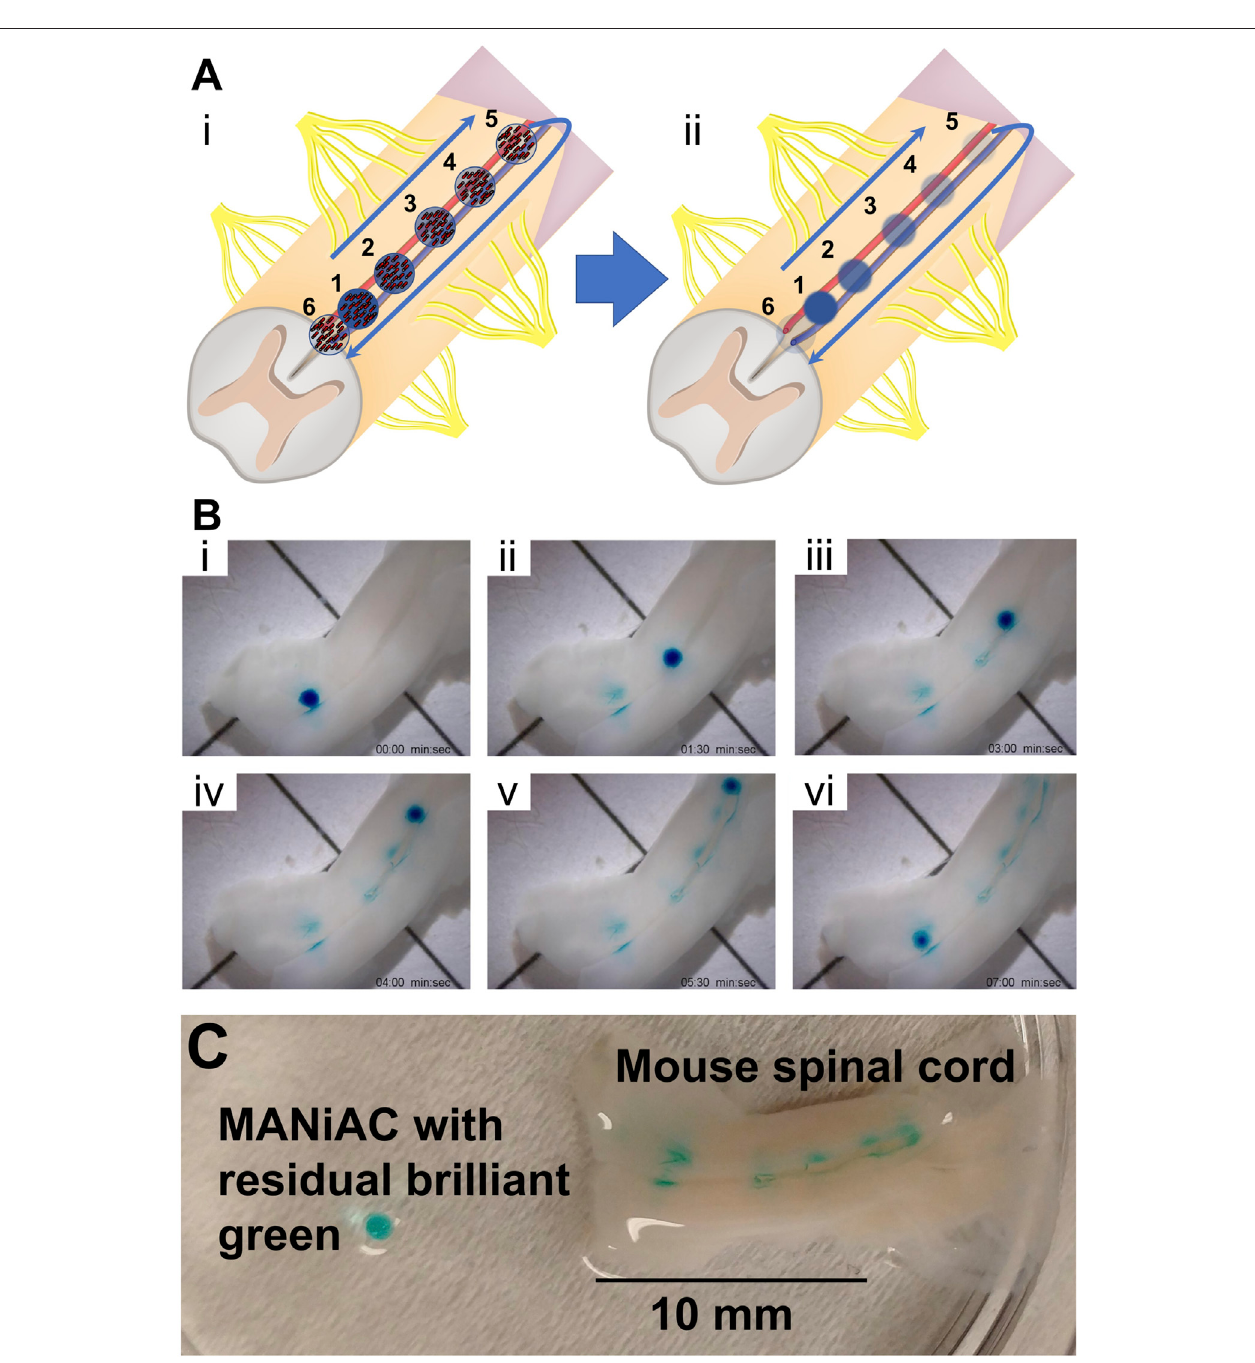
FIGURE 9 | Painting the mouse spinal cord. (A) Schematic of painting the spinal cord depicts [ (A), i] walking the MANiAC up and then back down the anterior median fi ssure of mouse spinal cord tissue, [(A), ii] painting the tissue in fi ve locations. (B) Five locations along the spinal cord are painted with BG dye [(B), i – v] and the MANiAC is fi nally repositioned at the original starting point [(B), vi] . (C) Final painted mouse spinal cord with removed MANiAC having residual brilliant green dye. The entire procedure took ∼ 7 min. Video included in Supplementary Information .